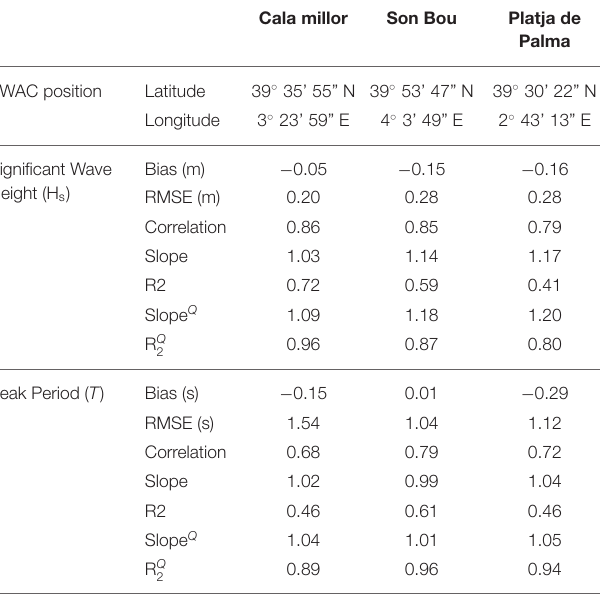
TABLE A1 | Coordinates of the AWACs used for the validation of wave propagations and metrics resulting from the comparison between the instrumental and the propagated time